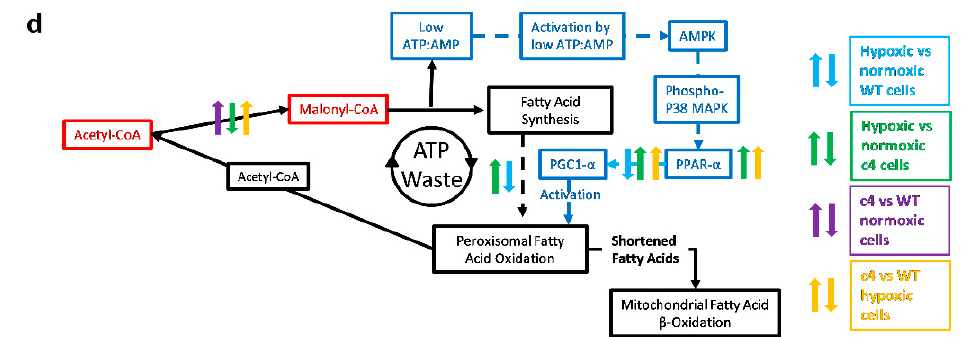
Figure 4. AMP/ATP-ratio-related signalling in Hepa-1 cells. ( a ) Hypoxia had opposing effects on PGC-1 α expression in WT and Hepa-c4 cells; there was a two-fold increase in PGC-1 α expression in hypoxic compared to normoxic Hepa-c4 cells ( p < 0.001, n = 9), ( b ) Hepa-c4 cells in both normoxia and hypoxia showed increased expression of phospho-p38 α MAPK (Thr180/Tyr182); this increase was significant for normoxic Hepa-c4 cells ( p < 0.01, n = 3), ( c ) PPAR α was increased by hypoxia in Hepa-c4 but not in Hepa-WT cells ( p < 0.001, n = 9), ( d ) Diagram showing expression differences and changes between the two Hepa-1 cell types in normoxia and hypoxia. N, normoxia; H, hypoxia (1% O 2 ); arrows pointing upwards suggest significant increase for a given comparison. Indicates differences in metabolic flux ( ↑ increased flux; ↓ decreased flux) due to HIF deficiency and hypoxia, which were inferred from changes in the relevant 13 C-labelled isotopomers Panels ( a – d ) show data expressed as mean ± SEM; statistical significance assessed by unpaired two-tailed t -test.